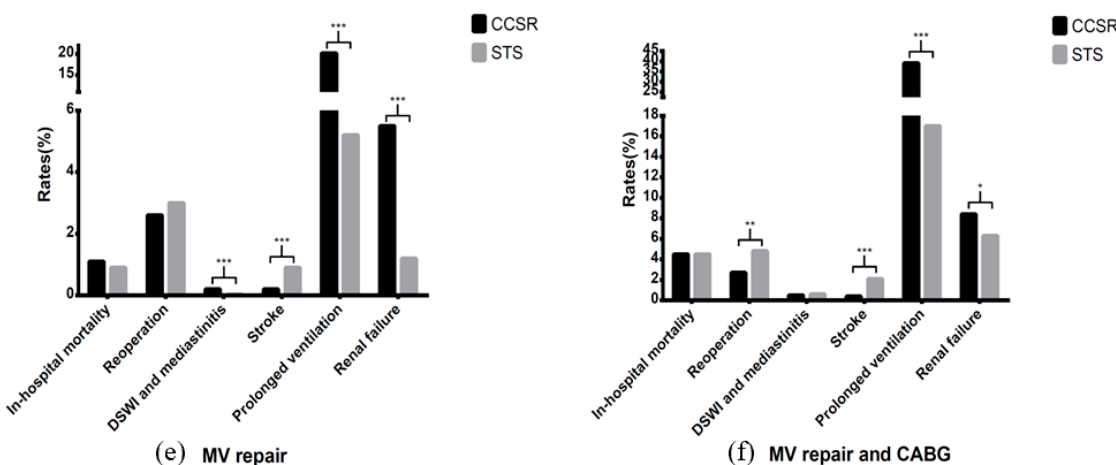
Figure 4. Comparison of outcomes in different procedures between CCSR and STS data. CCSR: Chi- nese Cardiac Surgery Registry; STS: Society of Thoracic Surgeons; AVR: aortic valve replacement; MVR: mitral valve replacement; CABG: coronary artery bypass grafting; DSWI: deep sternal wound infection. *: 0.01 < p ‐ value < 0.05; **: 0.001 < p ‐ value < 0.01; ***: p ‐ value < 0.001.